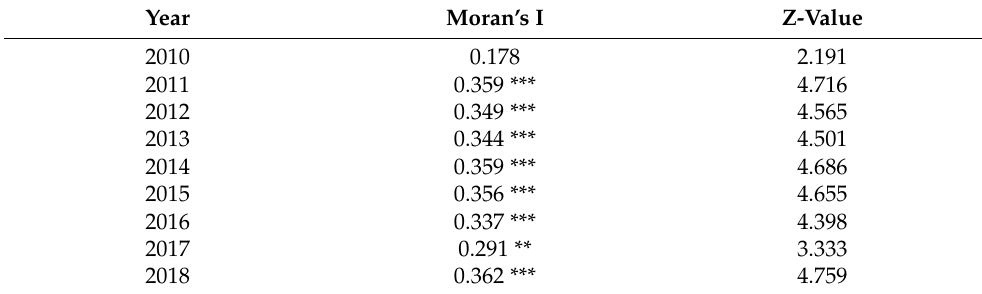
Table 7. Carbon emissions spread of characteristics in the transportation sector for